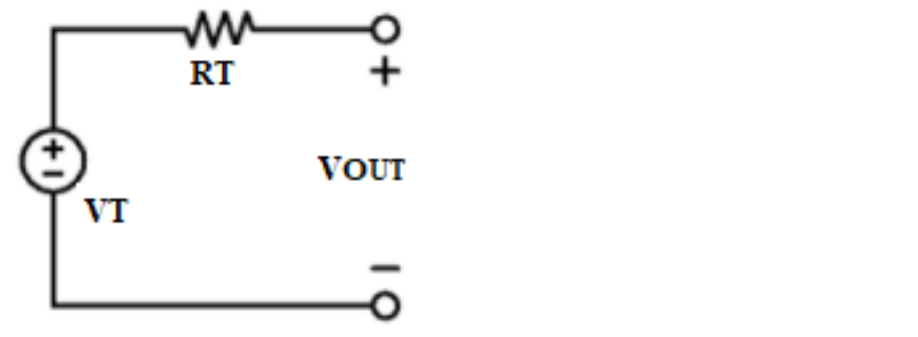
Figure 3. The equivalent circuit of a typical thermoelectric generator, where VT—constant voltage source; RT—equivalent internal resistance; VOUT—output voltage.